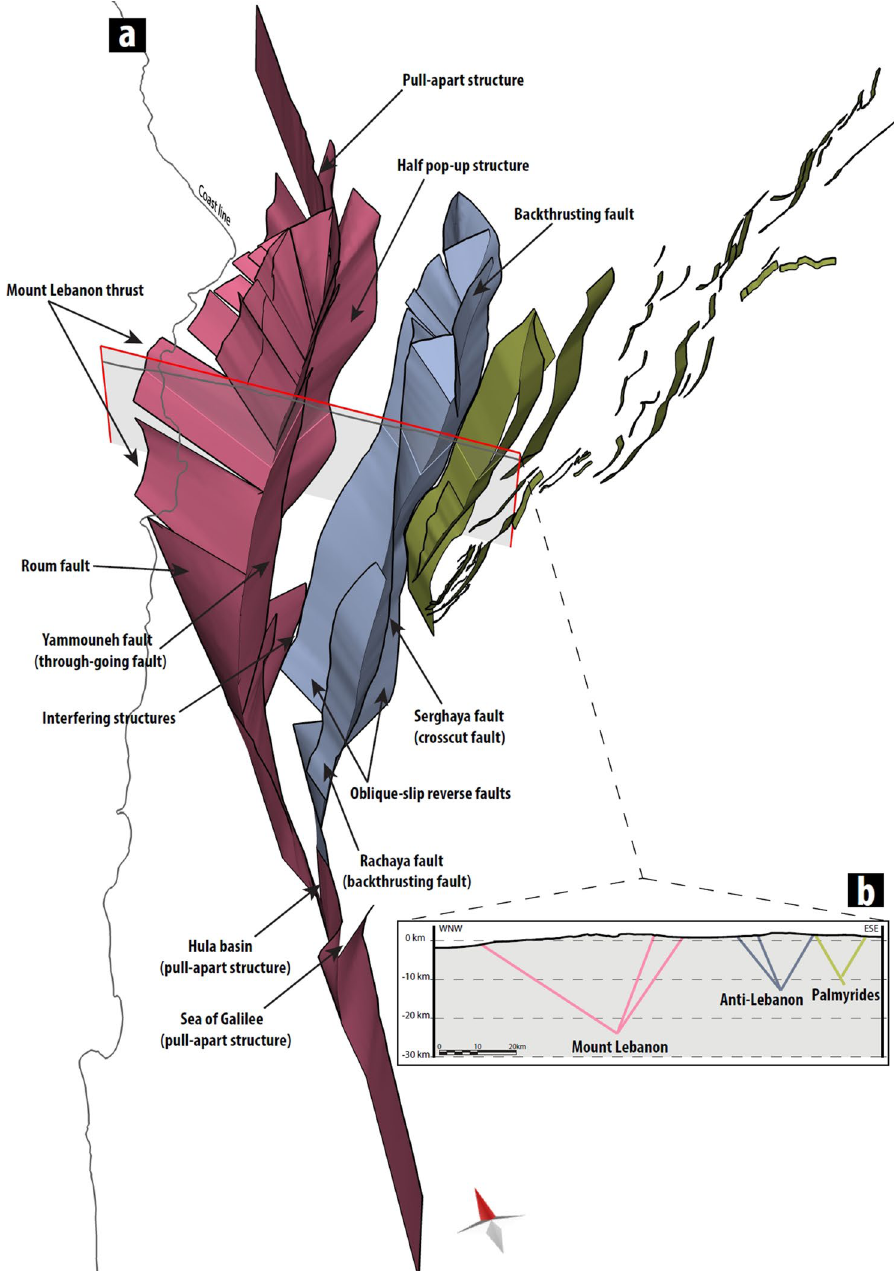
Figure 2. Model construction. ( a ) Three-dimensional (3D) northward view of Mt. Lebanon faults (in pink), Anti-Lebanon faults (in blue) and Palmyrides (in yellow), no vertical exaggeration. ( b ) WNW-ESE 115 km long section displaying intersecting faults of the Lebanon Restraining bend and the Palmyrides. Variable depth of PDZs were determined based on fault